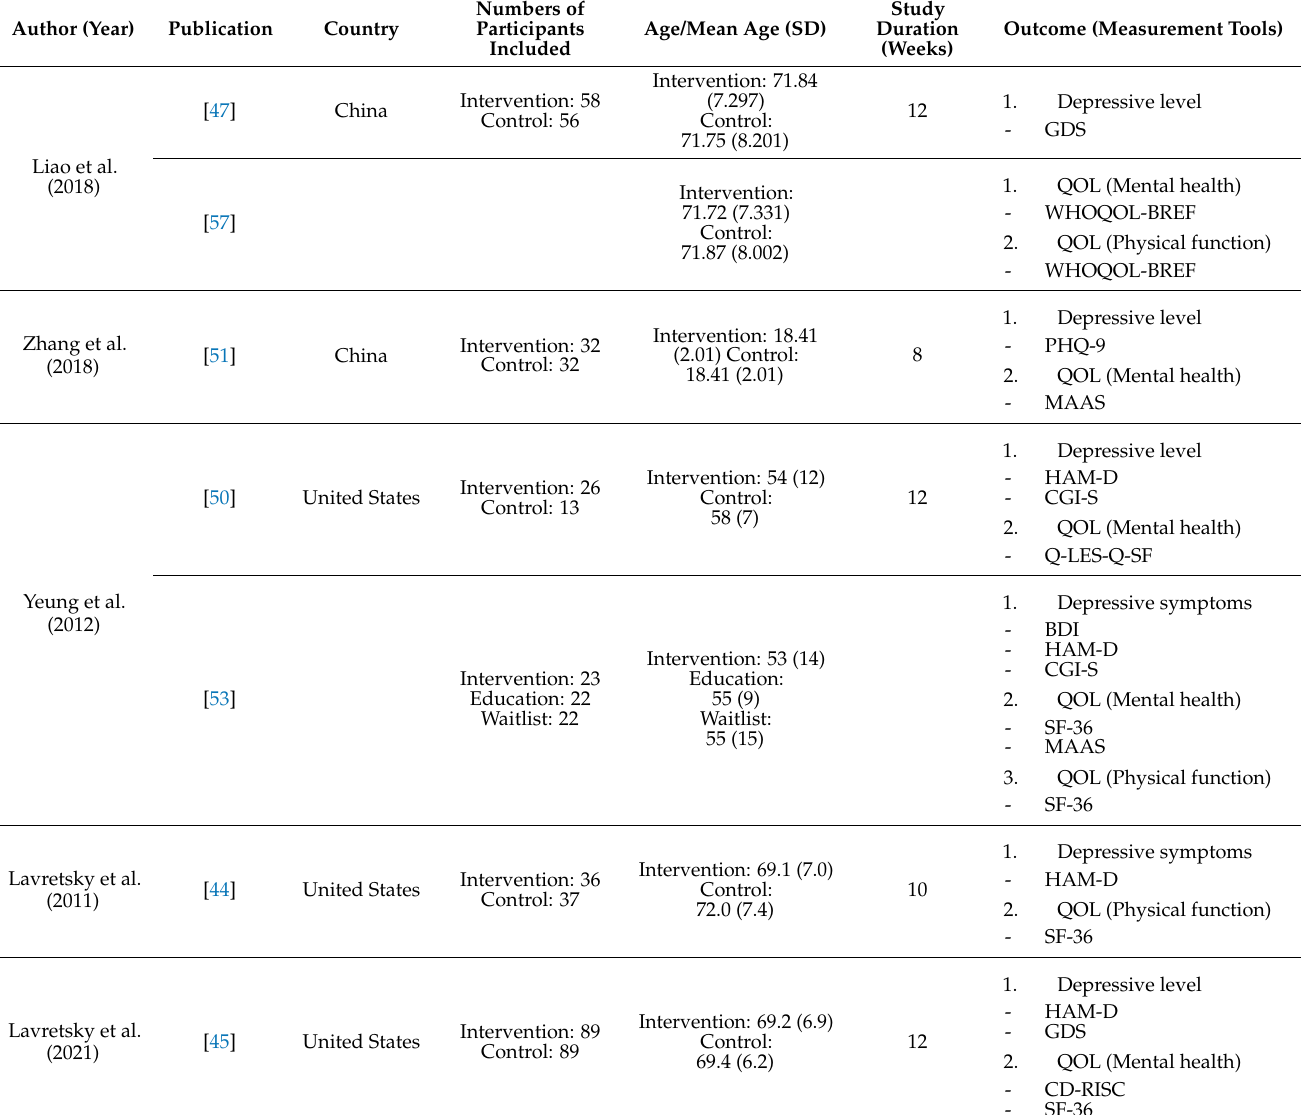
Table 1. Characteristics of the included